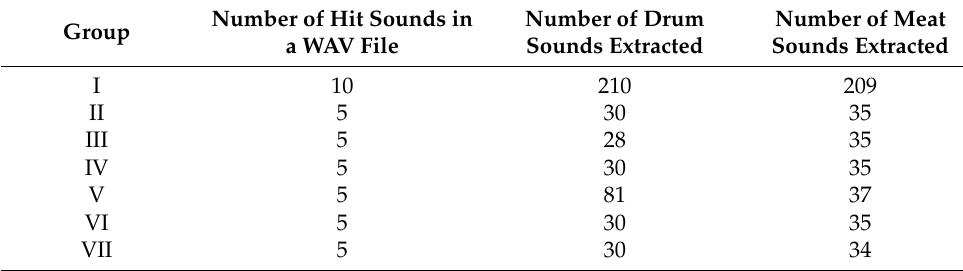
Table 5. Number of hit sounds